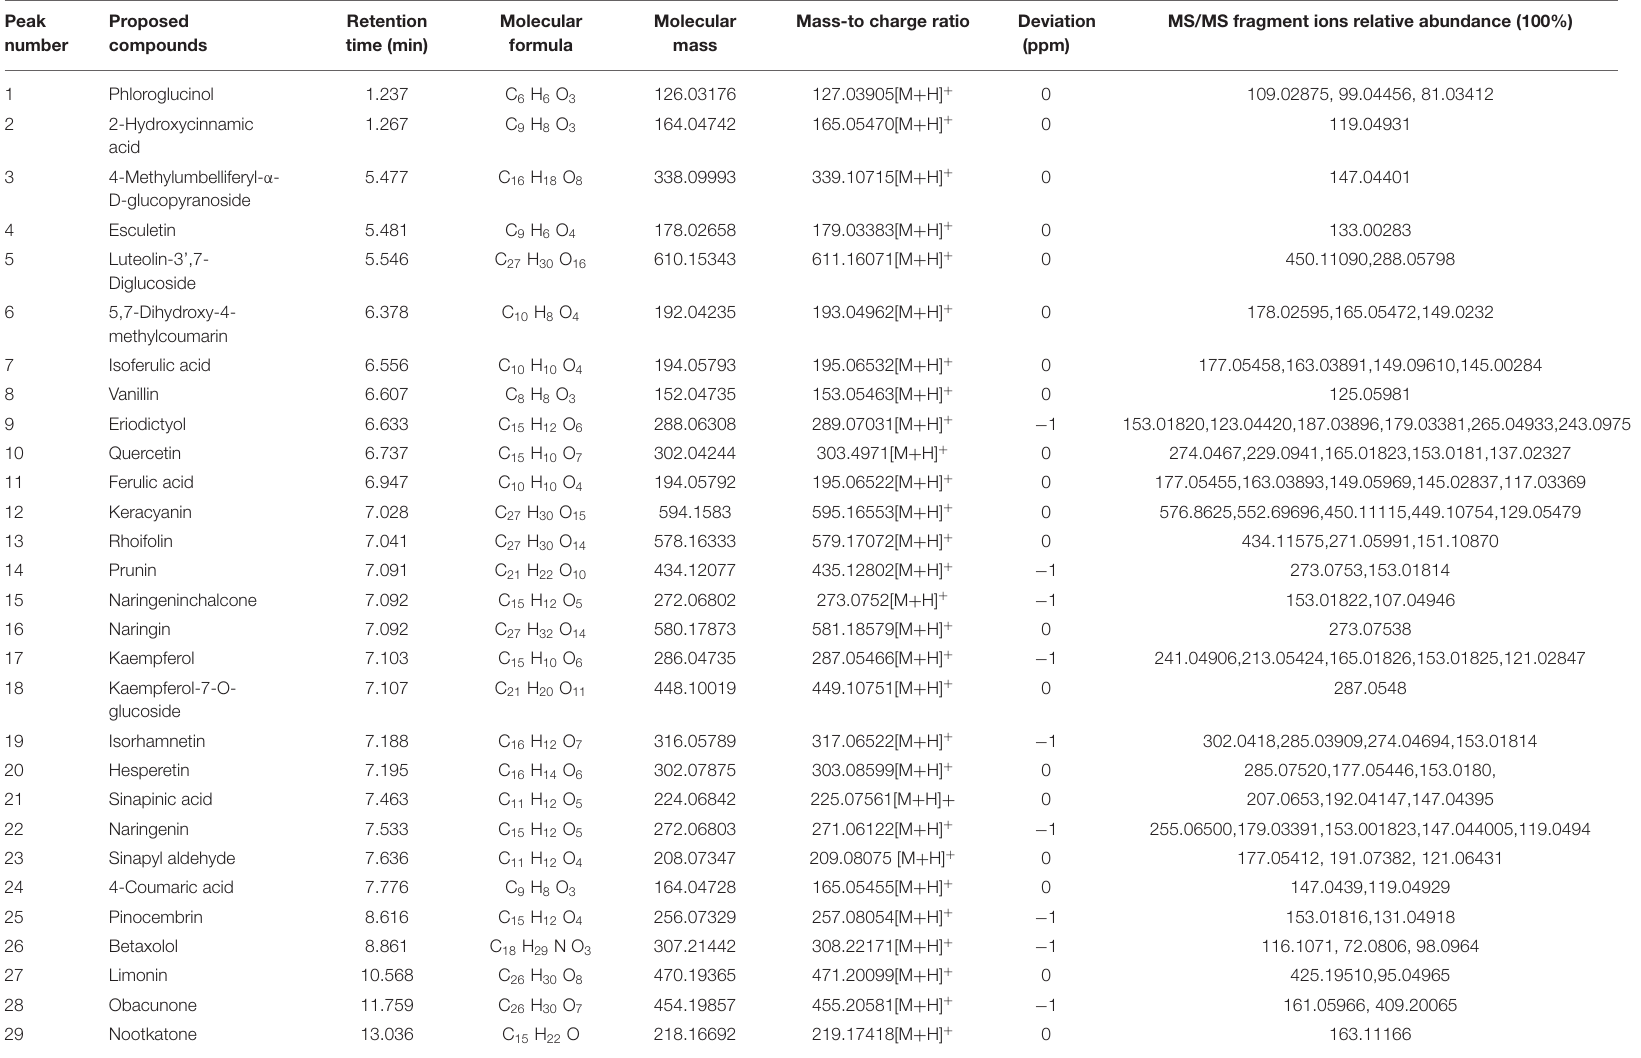
TABLE 1 | The characteristic components and their recognition results filtered by frequency in principal component